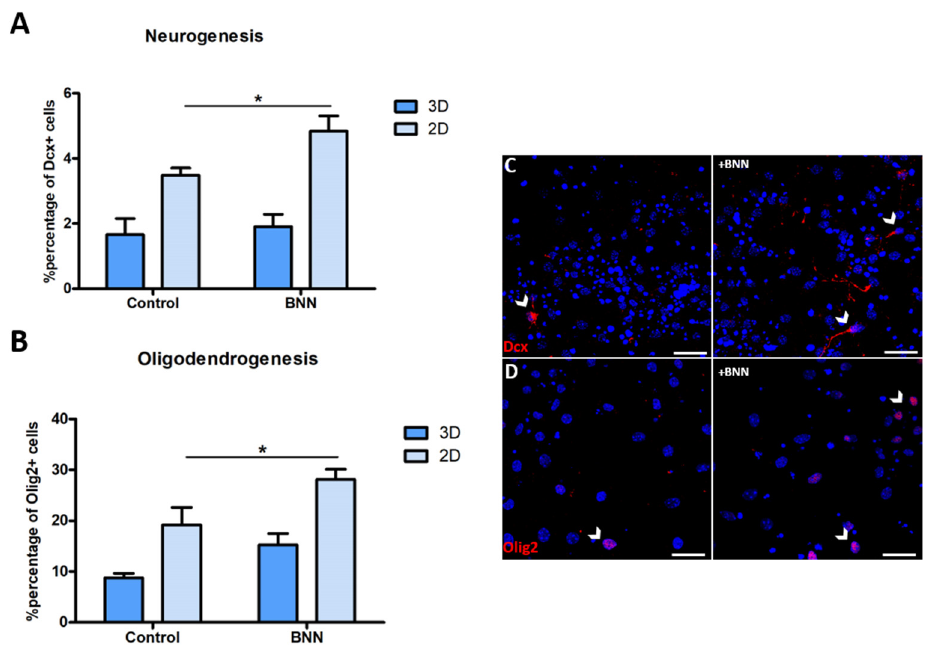
Figure 5. BNN-20 promotes neuronal and oligodendroglial cell fate only in the 2D microenvironments of polymorphic assays. ( A , B ) Graphs showing the percentage of Dcx+ (in A ) and Olig2+ (in B ) cells in 3D and 2D microenvironments, without or with the addition of BNN-20 to the differentiation medium for 7d (* p < 0.05, using paired t -test, n = 3). ( C , D ) Characteristic images of NSCs, differentiated without or with the addition of BNN-20, after immunostaining for Dcx ( C ) and Olig2 ( D ) (some positive cells are indicated with arrowheads). [Error bars: SEM; Scale bars, 30 μ m].